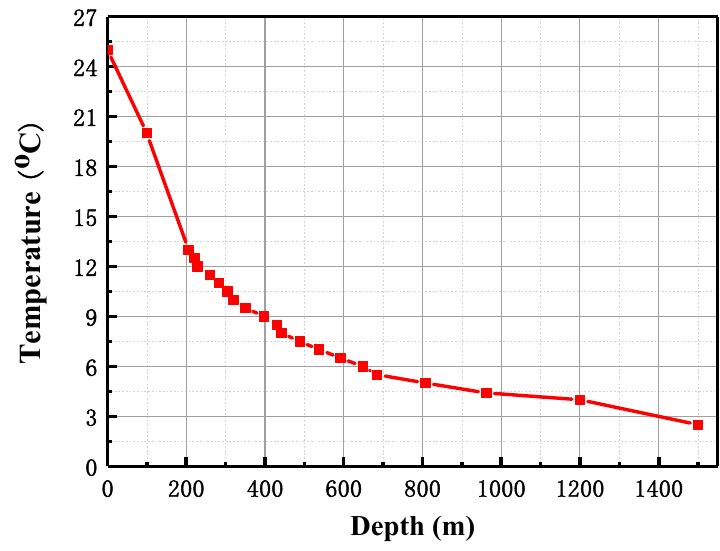
Figure 4. Seawater temperature graph. Table 1. Current parameters.